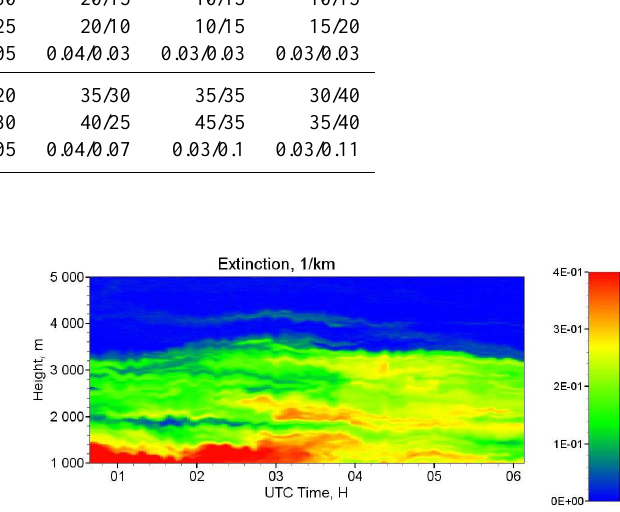
Fig. 4. Aerosol extinction at 355nm on the night of 20–21 July Fig.4. Aerosol extinction at 355 nm on the night of 20-21 July 2011 calculated by Klett method. calculated using the Klett